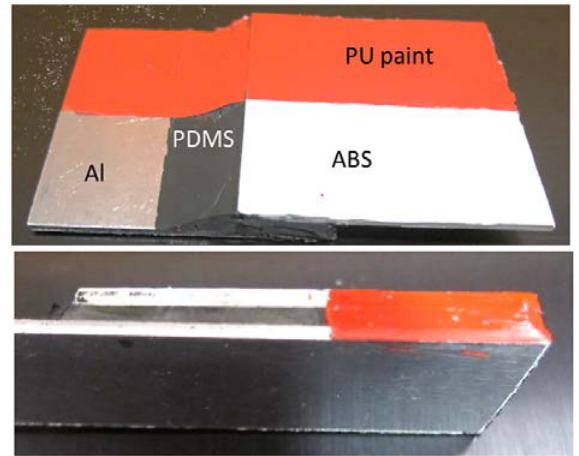
Figure 12. PU-based painted ABS–aluminium joined by PDMS (silicone).